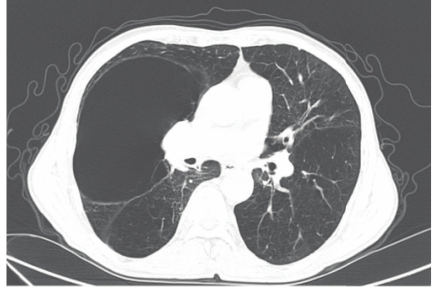
Figure 4: Posttreatment CT